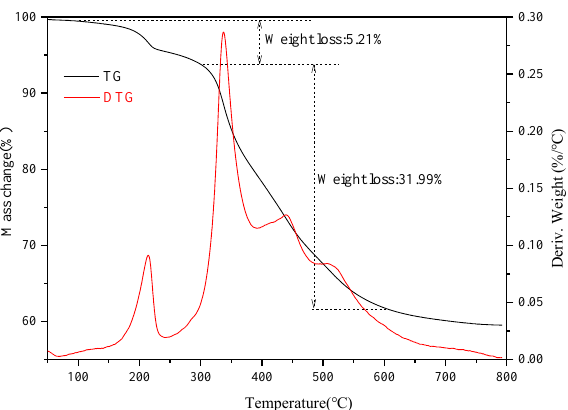
Figure 7. TG-DTG curve of the superhydrophobic bulk material.